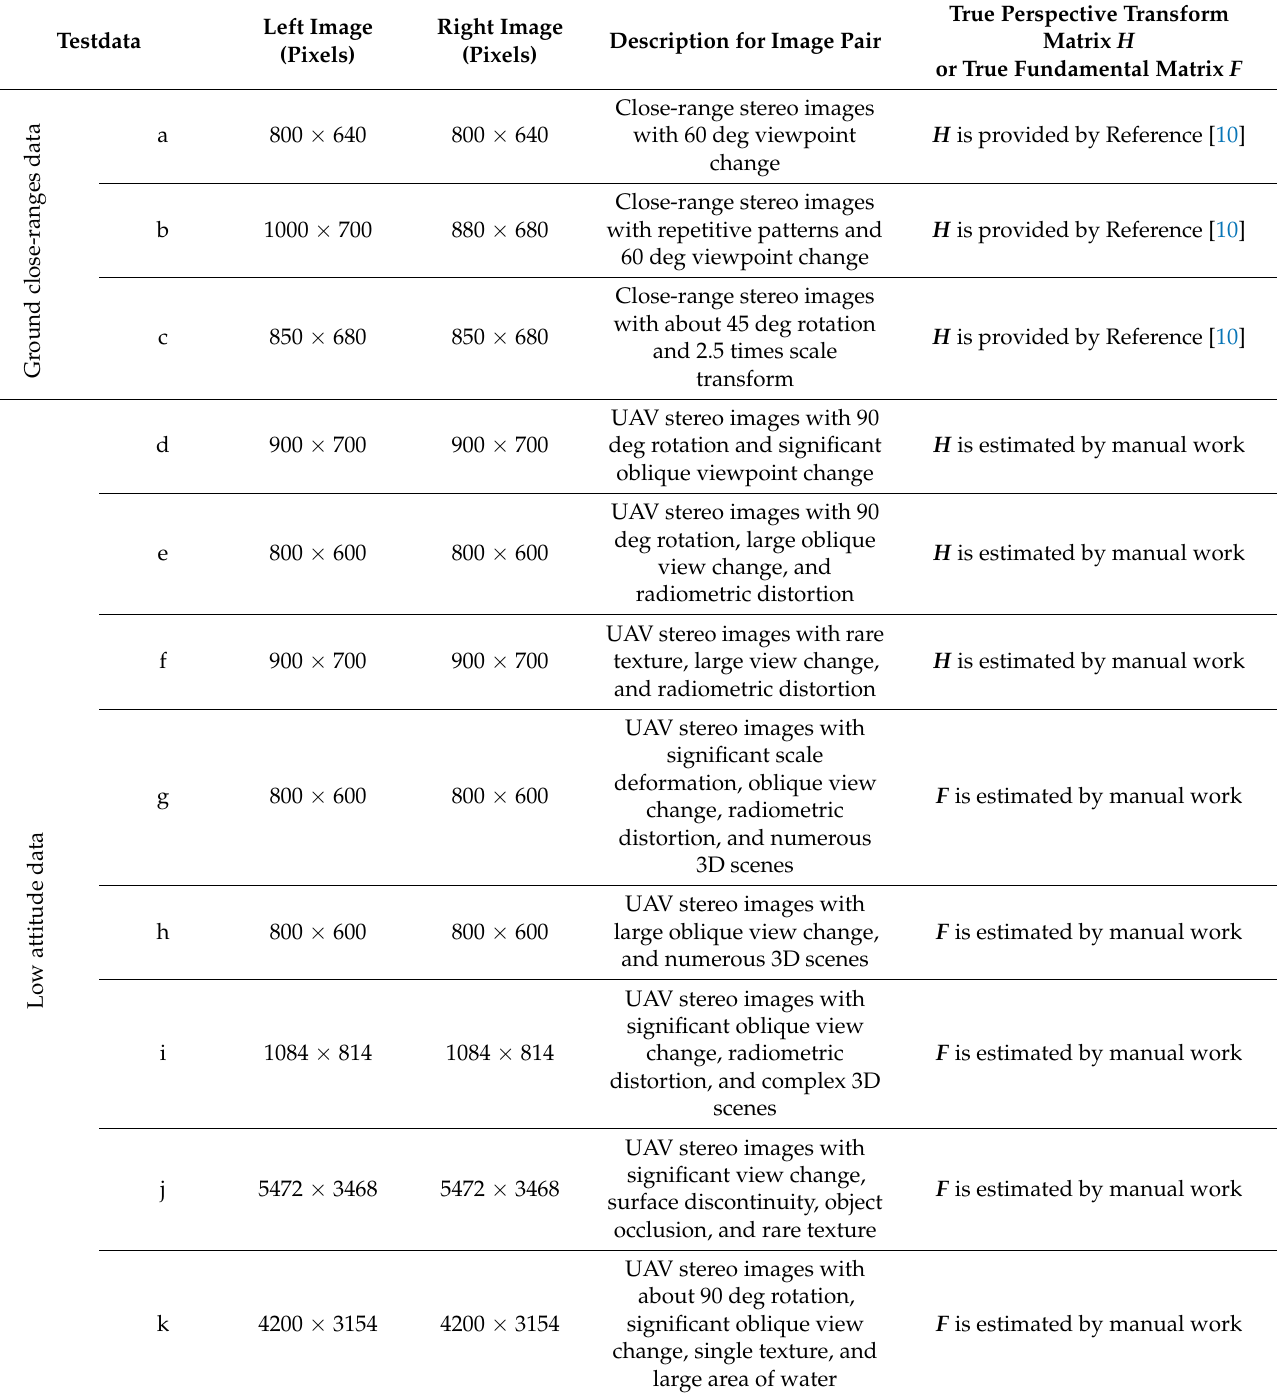
Table 2. Description of the wide-baseline test